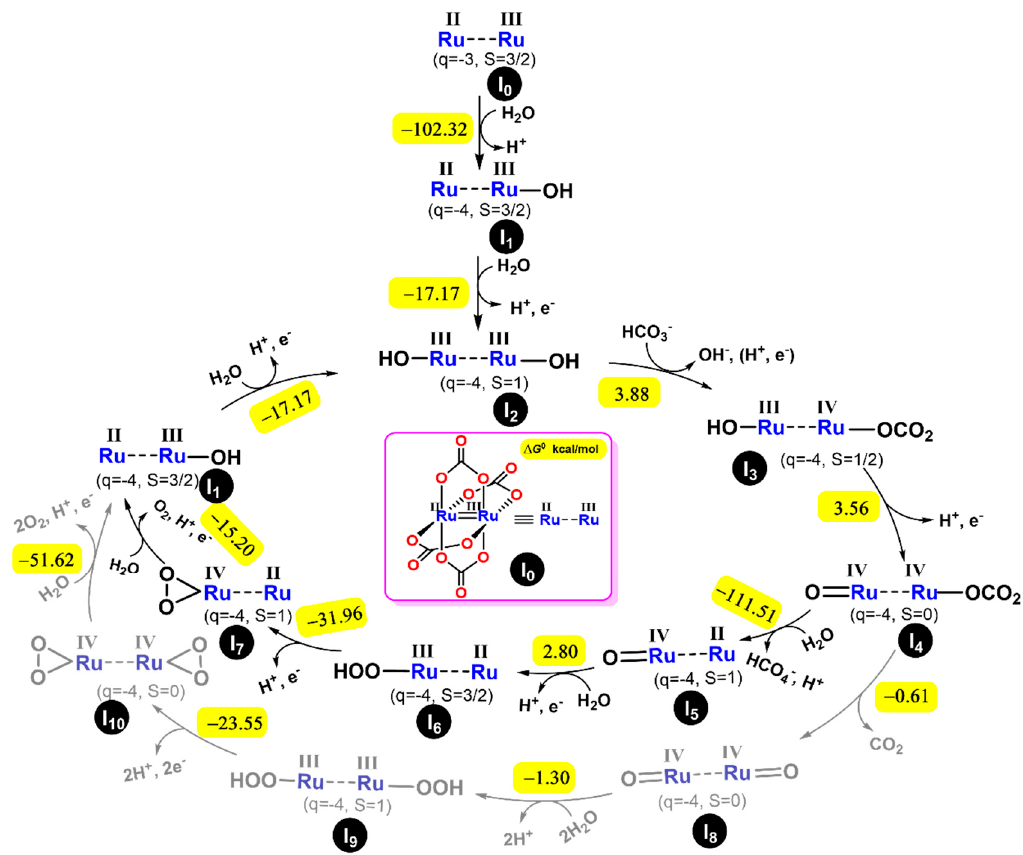
Figure 14. Schematic mechanism of the electrocatalytic water oxidation in the presence of [Ru III Ru II ( µ -CO 3 ) 4 ] 3 − ( I 0 ). The free energies of the reactions are highlighted in yellow ( Δ G , kcal/mol). The grey part represents the double site mechanism and the black one the single site mechanism. Table 1. Electronic and structural data for species involved in the water oxidation catalysts (WOC) mechanism.